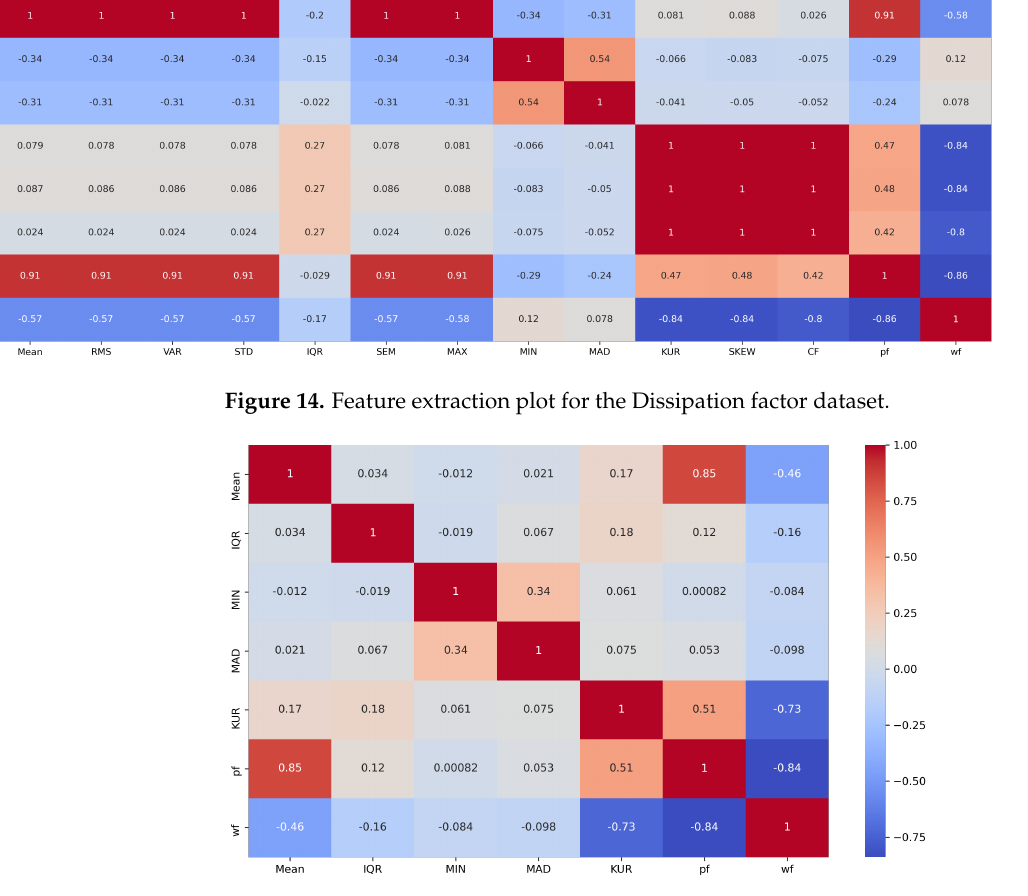
Figure 15. Feature selection plot for the Dissipation factor